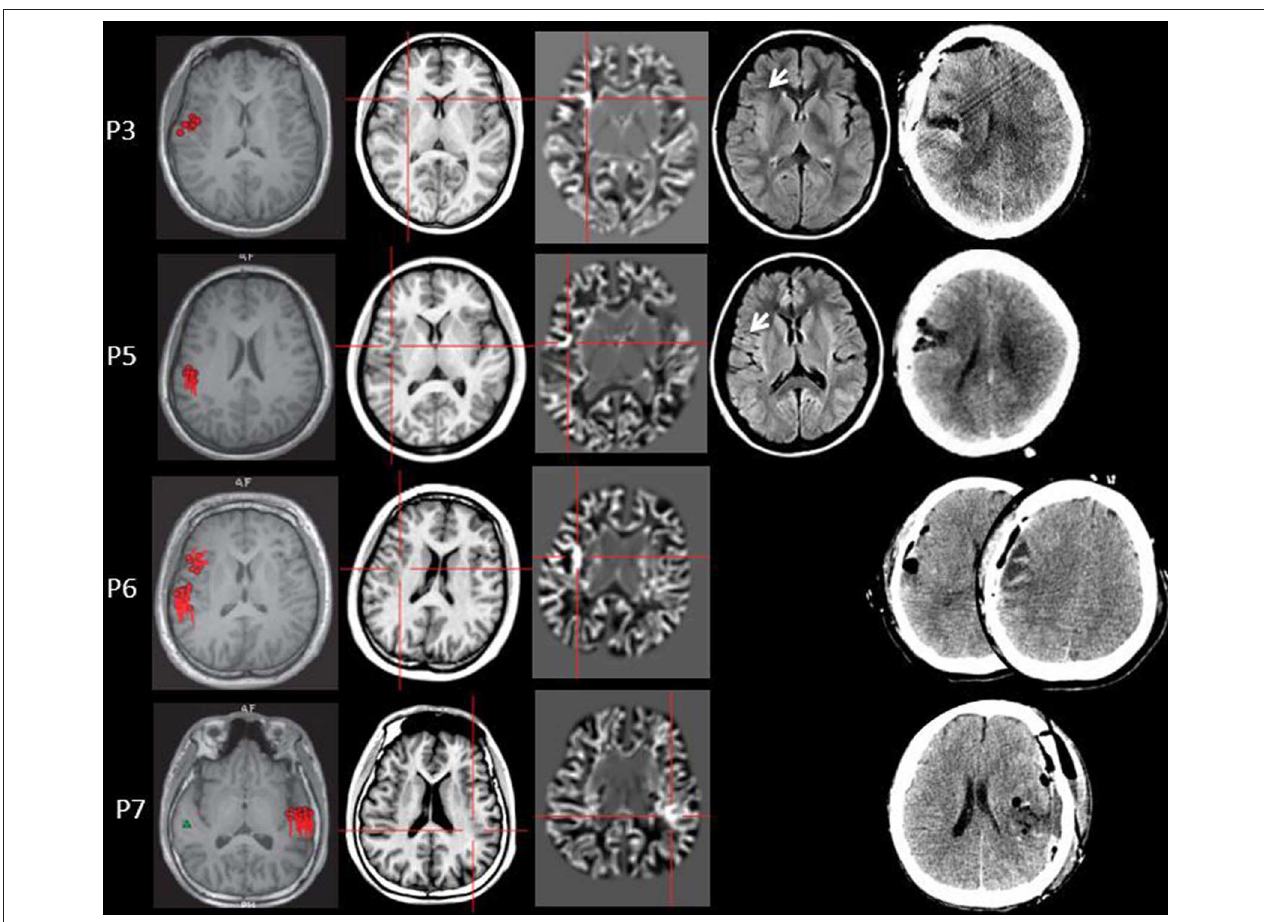
FIGURE 4 | The MEG, MAP, and post-surgical results of patients with positive MAP results (Patient 3, 5, 6, and 7). The crosshairs pinpoint the location of the MAP-positive region. First column: MEG results of Patient 3, 5, 6, and 7. Second column: T1-weighted magnetization prepared rapid acquisition with gradient echo (MPRAGE) images used as input to MAP. Third column: gray–white matter junction z-score file as the output of MAP. Fourth column: T2-weighted fluid-attenuated inversion recovery (FLAIR) images of P3 and P5; the FLAIR images of P6 and P7 were not available. Fifth column: post-operative CT scan indicating site and extent of resection. Three patients with positive MAP results (Patient 3, 5, and 7) had complete resection of the MAP-positive regions, and remained seizure-free at 12 months after surgery. One patient (Patient 6) had incomplete resection of the MAP-positive regions and this patient still had seizure at 12-month follow-up. Pathology: P3, FCD IIb; P5, FCD IIa; P6, FCD IIa; P7, FCD